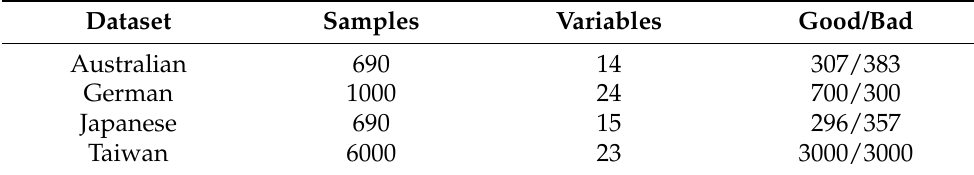
Table 1. Information of credit